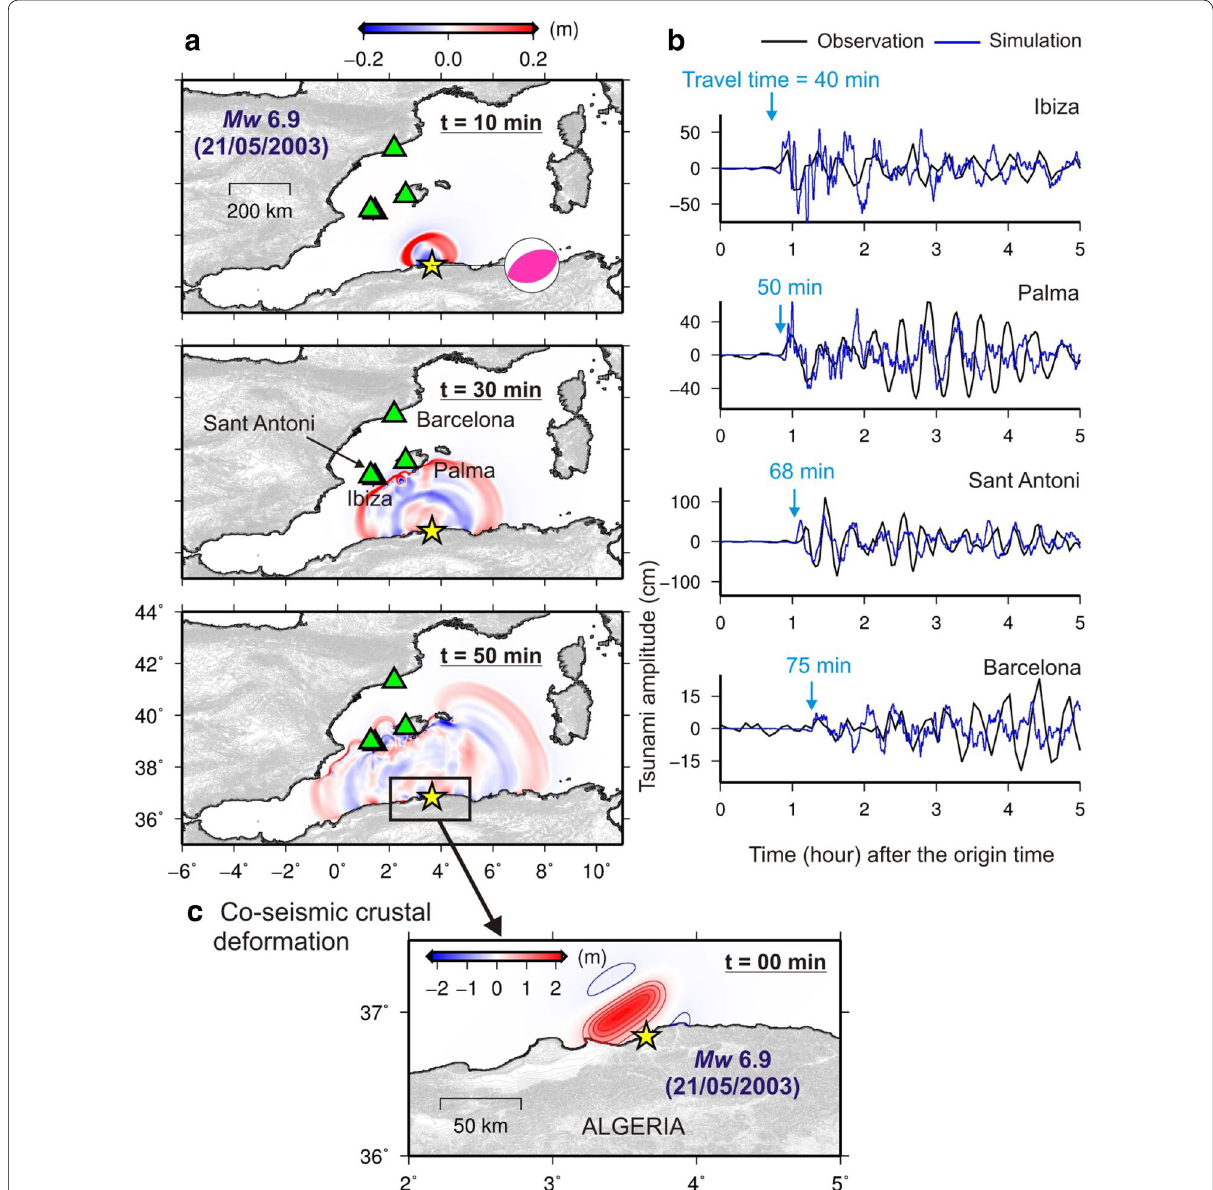
Fig. 3 a Tsunami snapshots of the 21 May 2003 (offshore Algeria) tsunami. b Observed (black) and simulated (blue) tsunami waveforms at tide gauges. c The source model used for simulation which is based on that proposed by Heidarzadeh and Satake (2013). Note that the two stations of Ibiza and Sant Antoni are very close to each other and their symbols are overlapped. Sant Antoni station is located to the west on